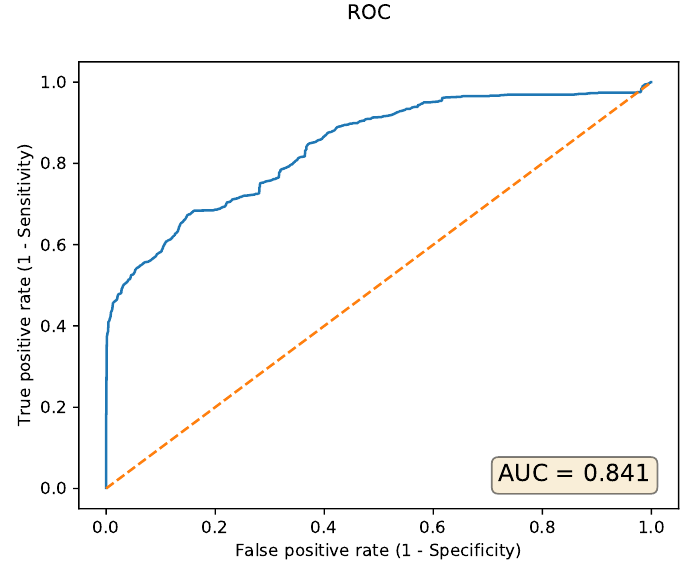
Figure 11. The area under the operating characteristic curve (ROC) curve for the CICIDS 2017 autoencoder with a 70-50-20-50-70 neurons per layer